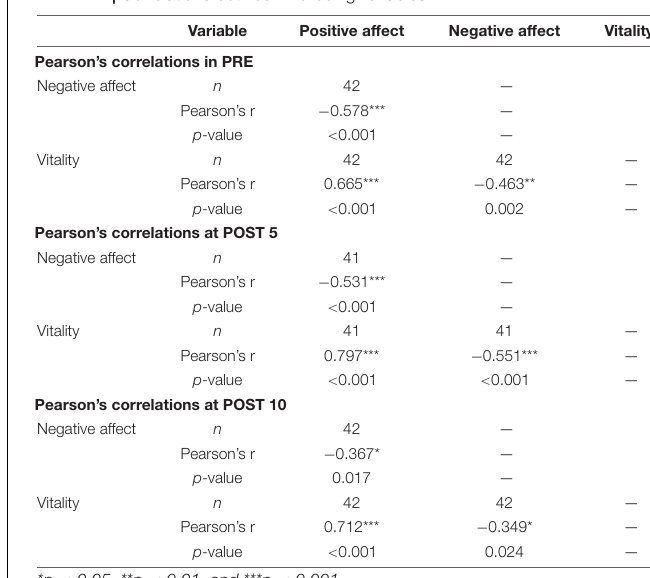
TABLE 2 | Correlations between wellbeing